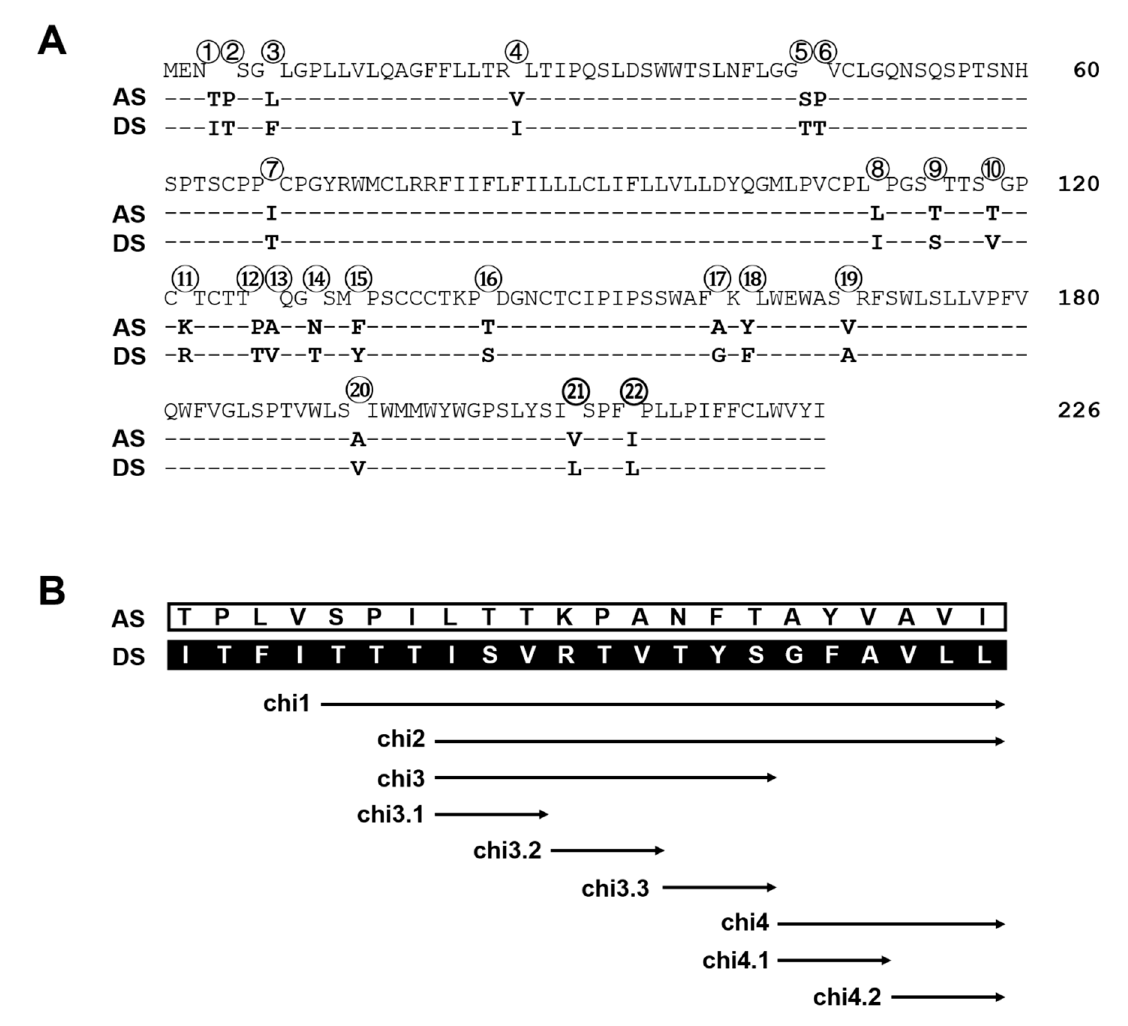
Figure 7. Divergent residues in the S protein between geno5.4 and geno1.2 and chimeric constructs to map the determinants for efficient HBsAg secretion. ( A ) The 22 divergent residues between geno5.4 and geno1.2 on the S protein of 226 residues. ( B ) The nine pairs of chimeric constructs of the S region between geno5.4 and geno1.2.